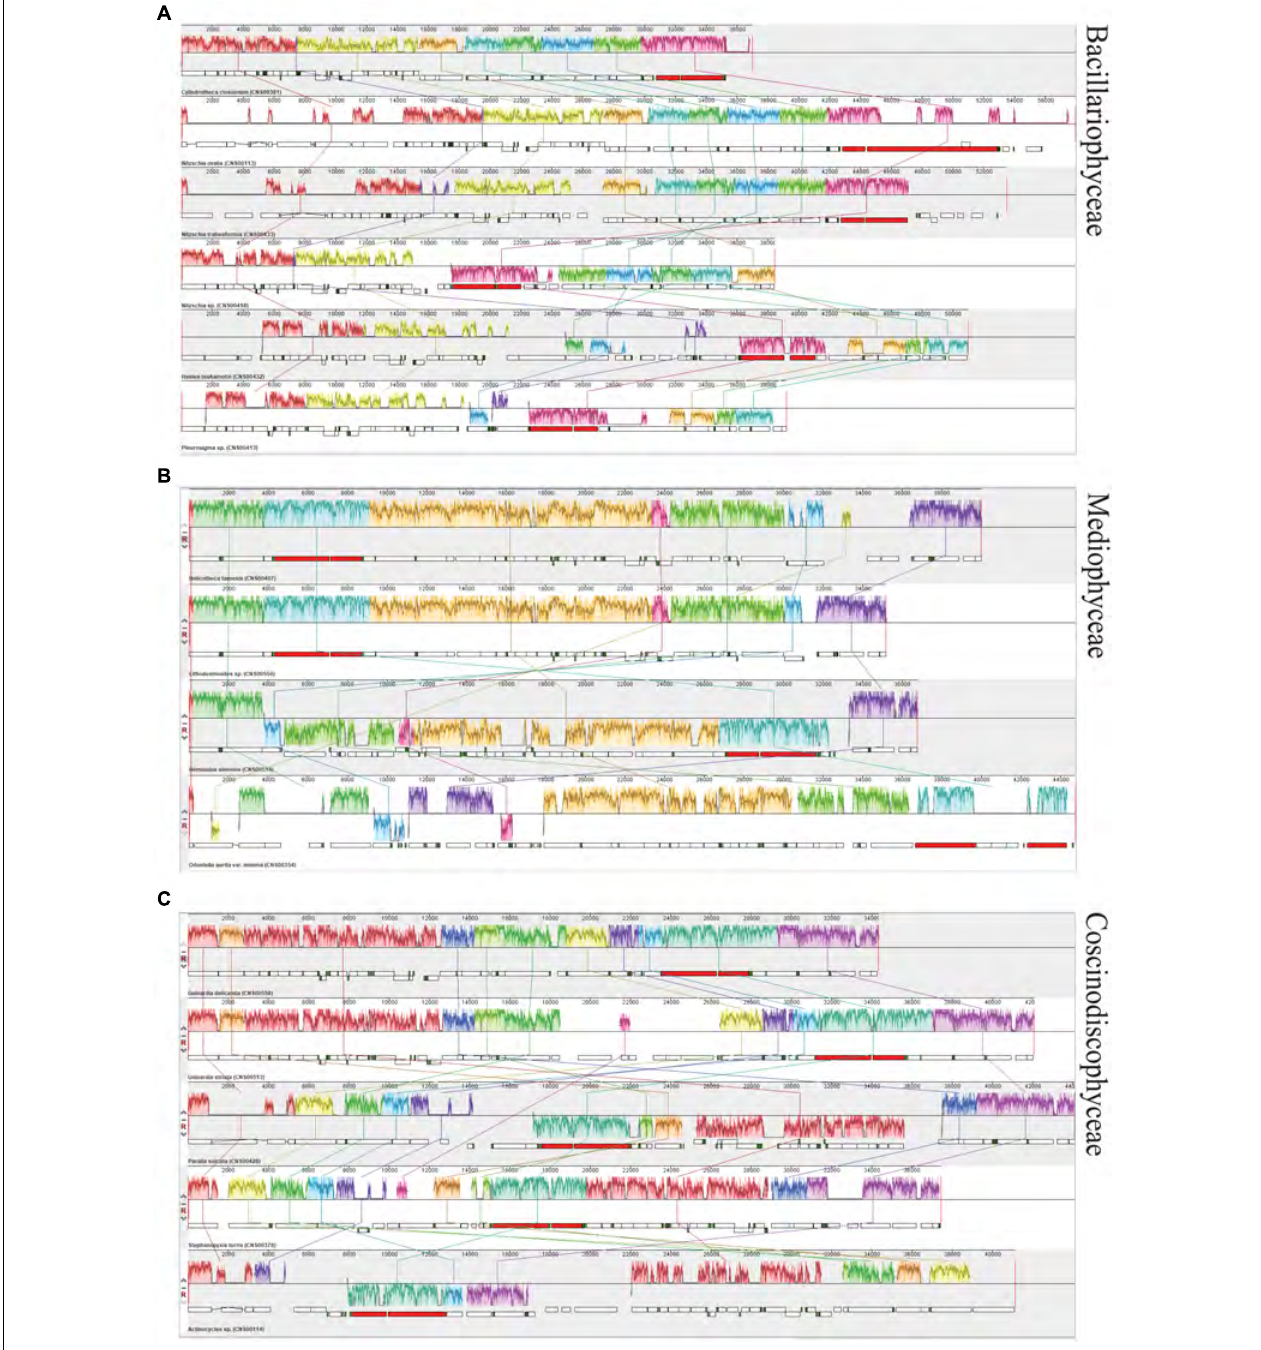
FIGURE 7 | Synteny analysis of diatom mtDNAs constructed in this study. (A) Synteny relationships among six newly constructed mtDNAs of Bacillariophyceae based Mauve analysis. (B) Synteny relationships among four newly constructed mtDNAs of Mediophyceae. (C) Synteny relationships among five newly constructed mtDNAs of Coscinodiscophyceae. Each colored block indicates a synteny block among different mitochondrial genomes.